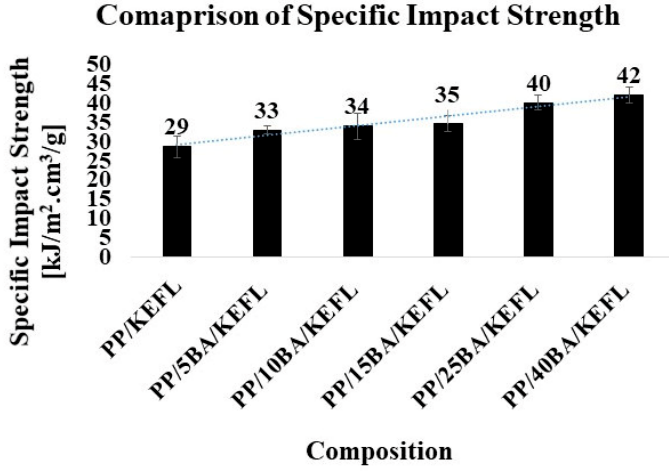
Figure 7. Specific impact strength of PP composites with bast and hybrid bast/BA fibers.